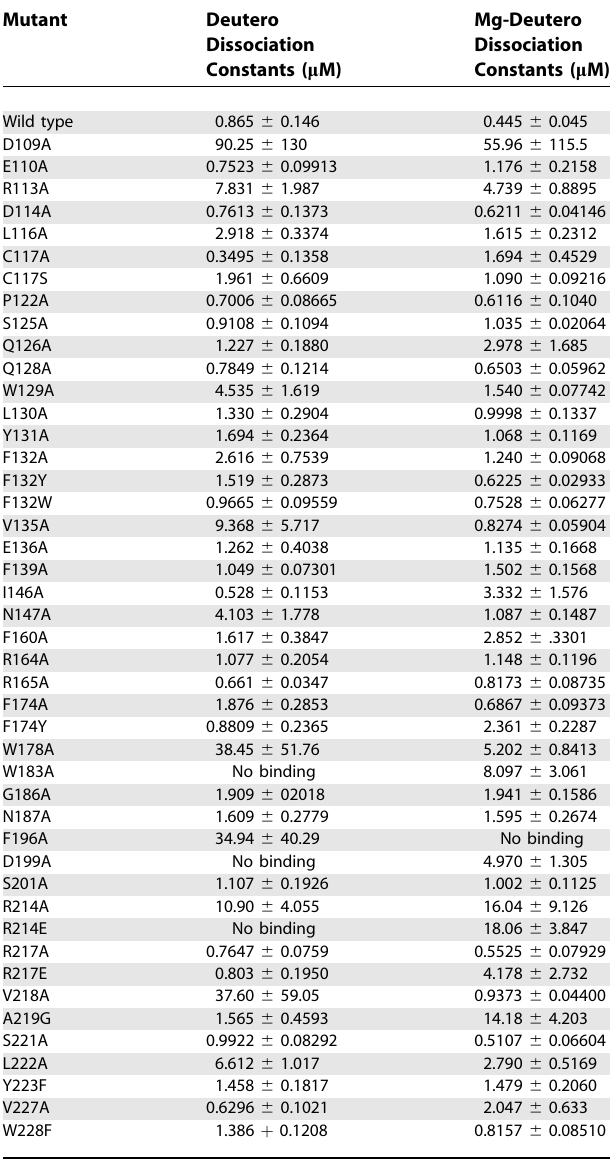
Table 2. Dissociation Constants of SynGUN4 Proteins for Deutero and Mg-Deutero Mutant Deutero